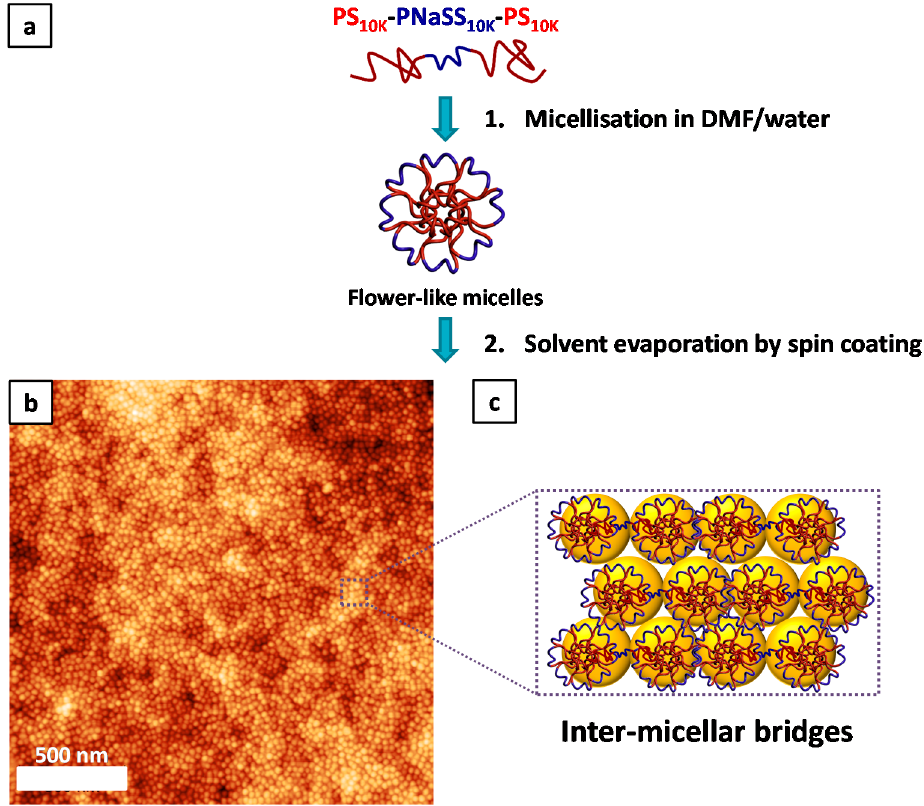
Figure 2. ( a ) Micelle and thin film formation ( b ) AFM image of the film formed using the copolymer micelle solution ( c ) Representation of the inter-micellar bridges between the flower-like micelles maintaining the film structure.